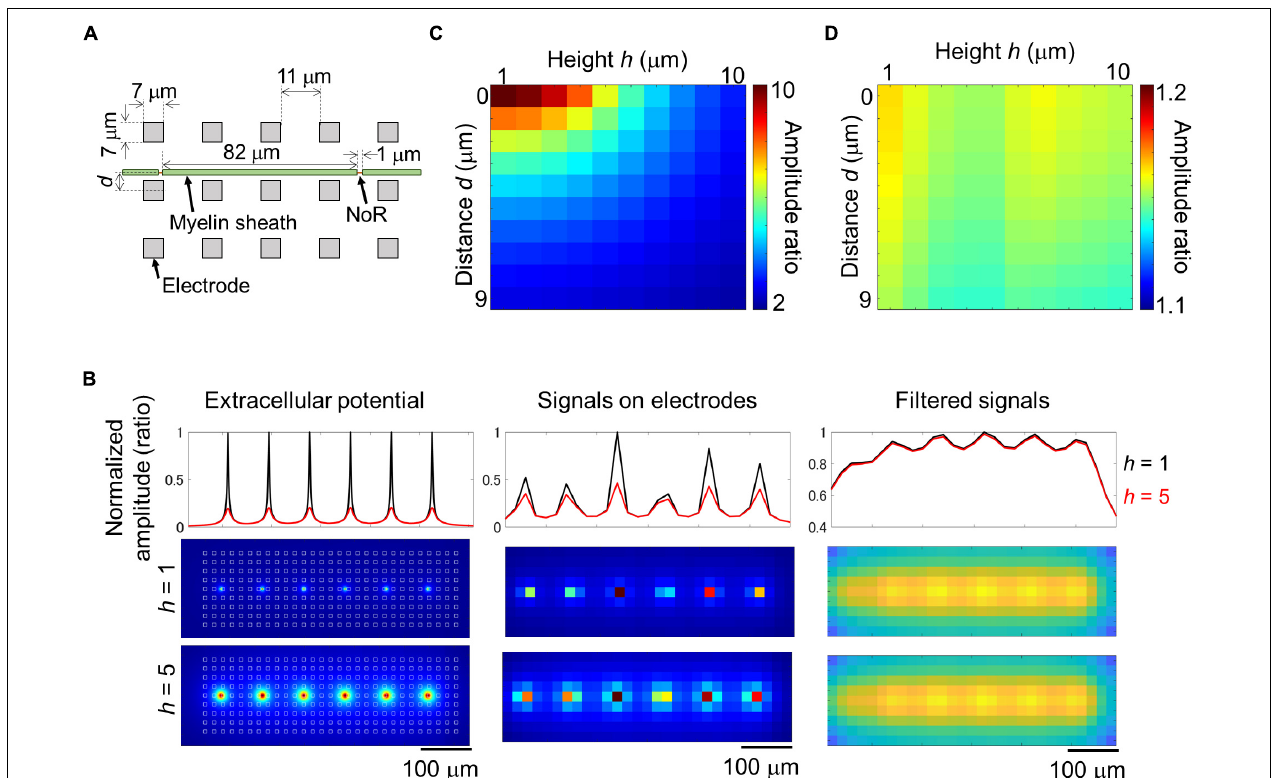
FIGURE 6 | Simulation of extracellular potential along myelinated axon. Structural parameters of the simulated myelinated axon and electrodes (A) . Maximum amplitude of extracellular potential around the myelinated axon at 1 µ m mesh [ (B) left panels], and on electrodes [ (B) center and right panels]. Recorded signal was simulated with 2D median and Gaussian filters (right panels, filtered signal). White squares in panel (B) left panel shows the position of electrodes. Black and red lines show normalized amplitude at the heights of 1 and 5 µ m. As the height between axon and electrodes increased, the amplitude at the node of Ranvier (NoR) decreased [ (B) top panels]. Relationship between the distance and height and amplitude ratio calculated from the amplitude of electrodes under NoR and myelin sheath [ (C) unfiltered; (D) filtered]. Note that the distance caused few effects on the amplitude ratio of the filtered signal as shown in panel (D)